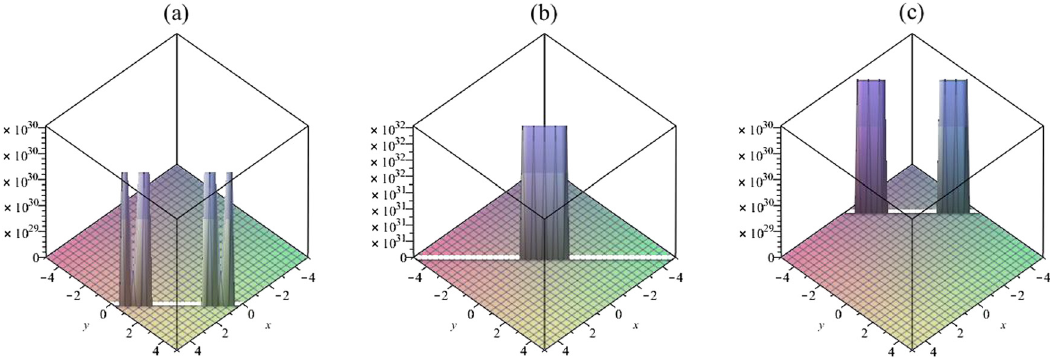
Figure 2: The propagation of solutions u s 1 with k l s 1 = = = , τ 0 = , η 1